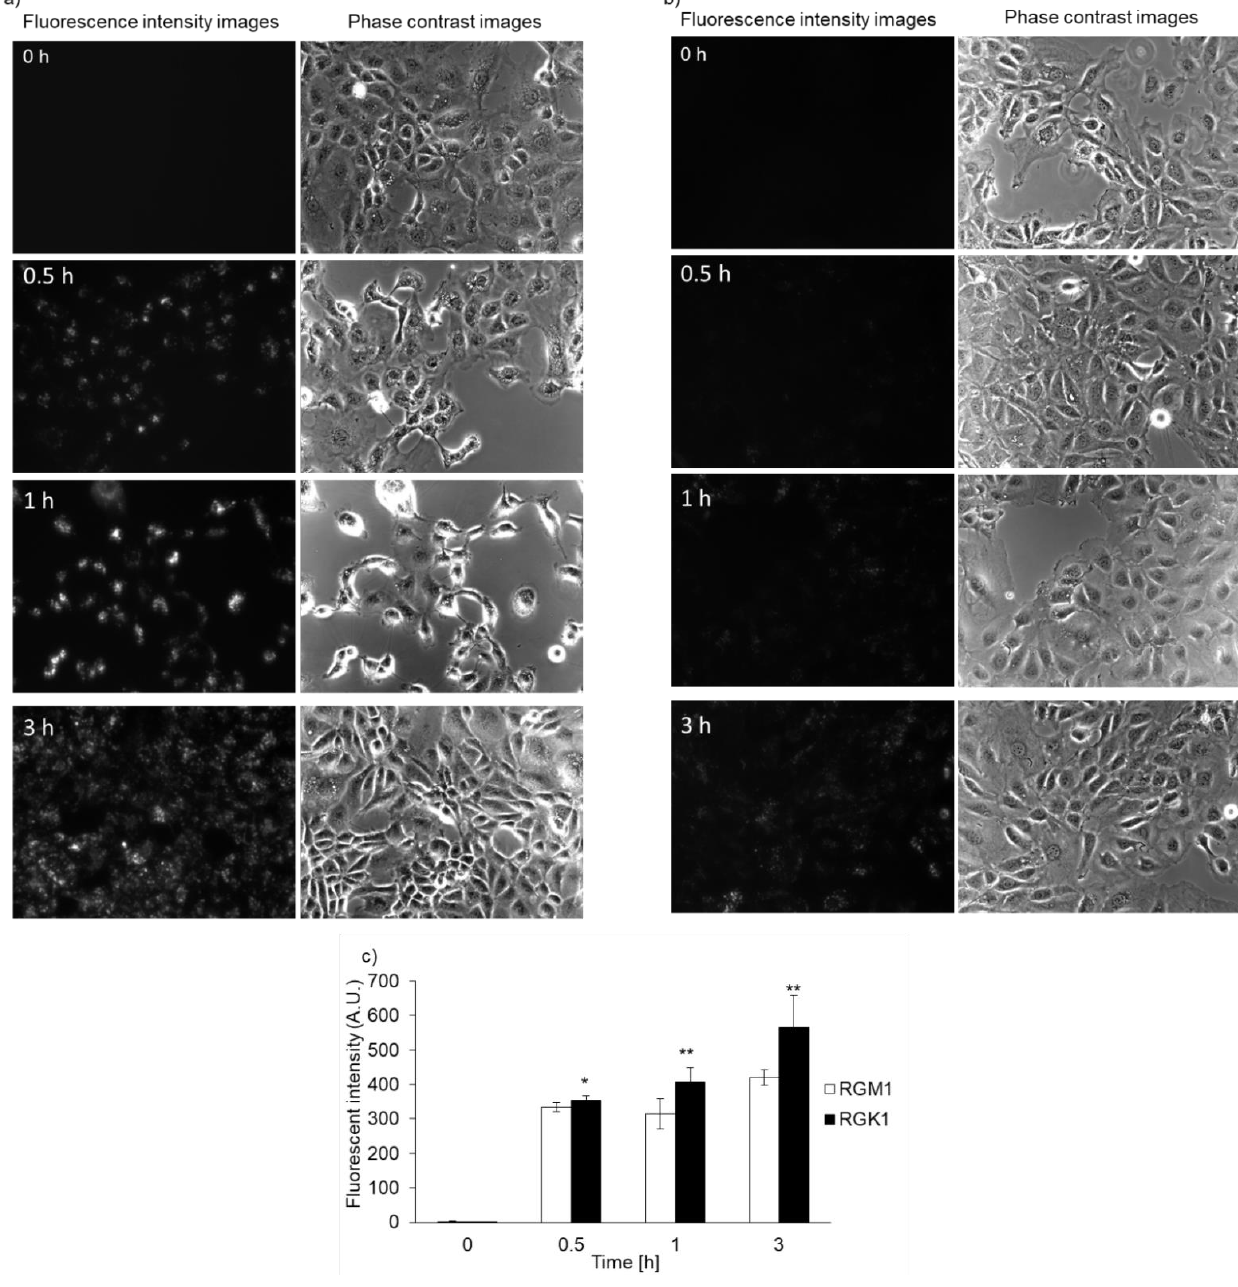
Figure 2. Intracellular PLP accumulation. Microscopy images of RGK1 ( a ) and RGM1 ( b ). Intracellular fluorescence intensity of PLP was measured using a microplate reader ( c ). Data are expressed as means ± SD ( n = 5). * p < 0.05, ** p <